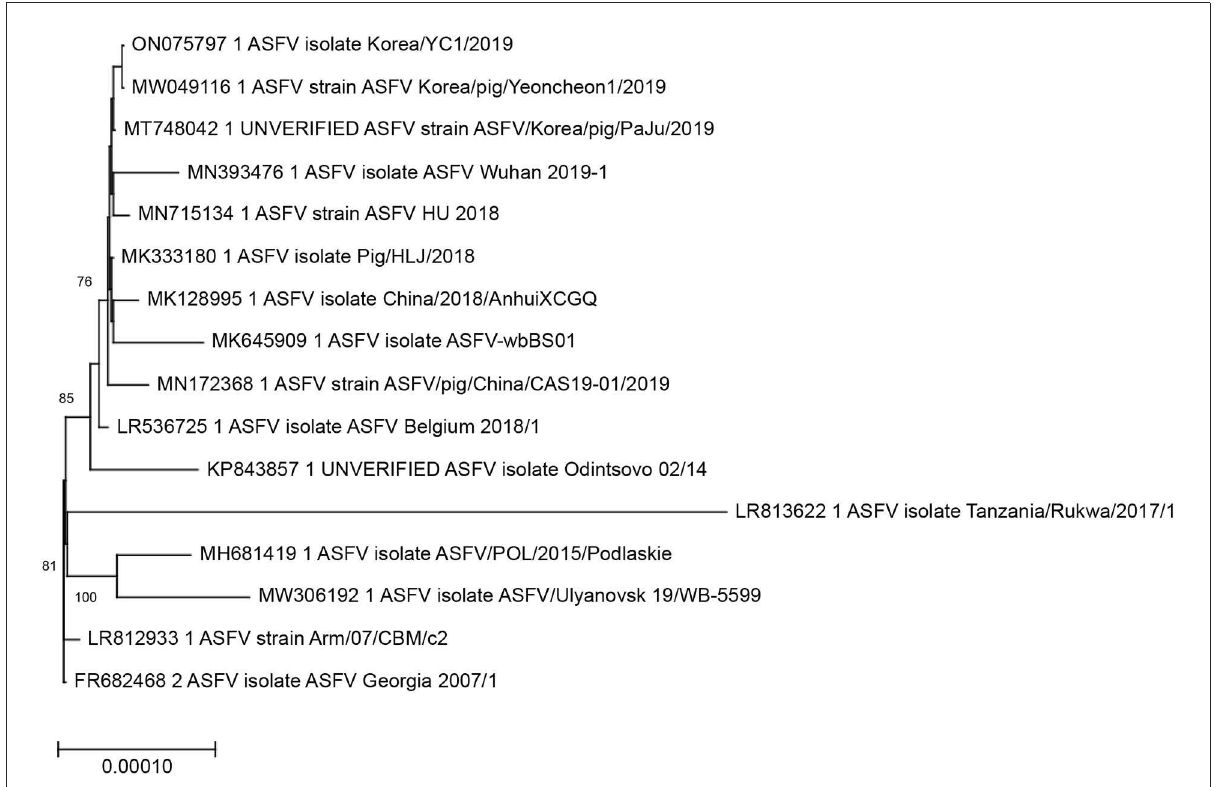
FIGURE4 Maximum-likelihood analysis of 16 complete coding sequences of ASFV including the Korea/YC1/2019 strain sequenced in this study. The phylogeny was rooted at the Georgia/2007 virus. The scale bars show the number of substitutions per site. The numerical values represent 1,000 bootstrap replicate values > 70 expressed as a percentage.